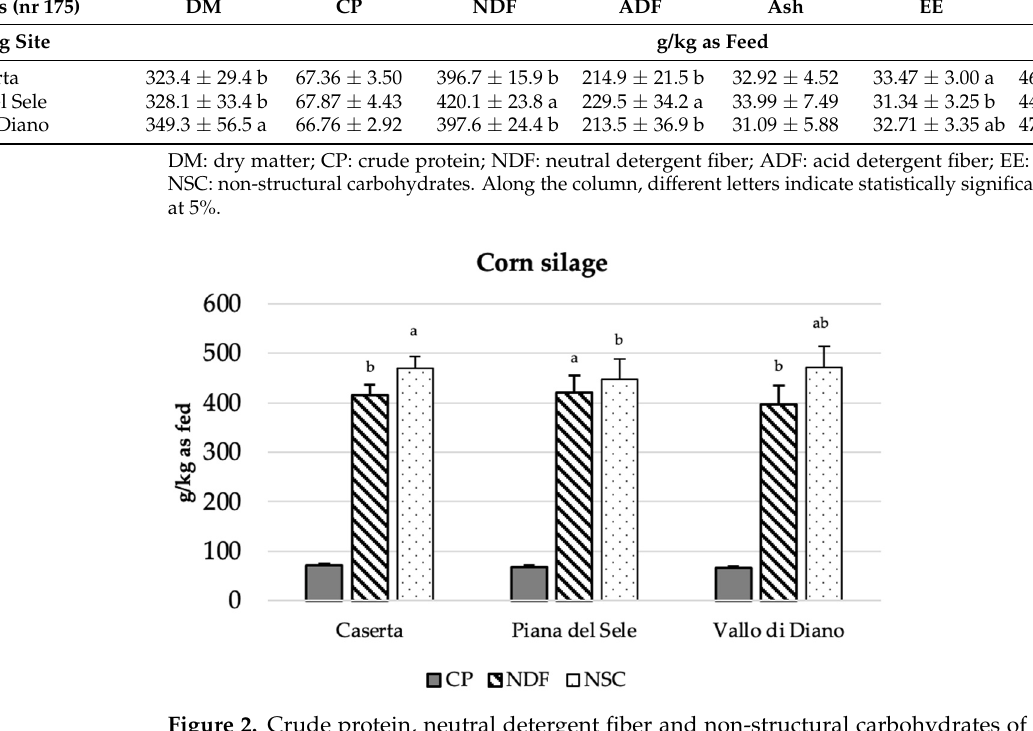
Table 3. Chemical composition (mean ± SD) of corn silages according to the sampling site. Corn Silages (nr 175)